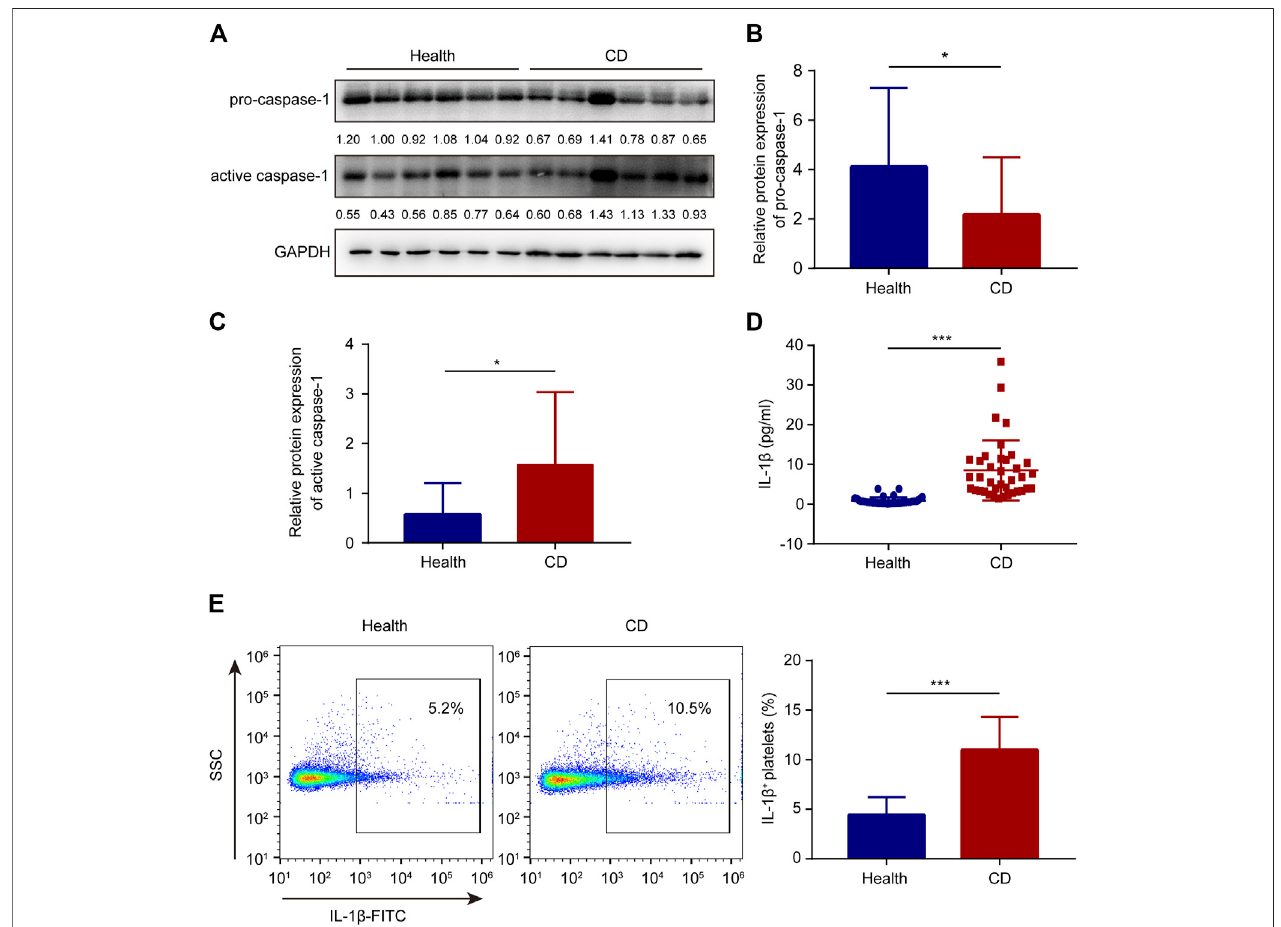
FIGURE 3| Increased interleukin-1 β and active caspase-1 in platelets from patientswithactive Crohn ’ s disease (CD). (A) The protein levels ofcaspase-1 and pro- caspase-1 in platelets from the healthy group and patients with active CD. (B,C) The relative protein quanti fi cation of pro-caspase-1 (B) and active caspase-1 (C) was determined ( n (cid:2) 38). (D) Serum interleukin-1 β levels were determined in the healthy group ( n (cid:2) 38) and patients with active CD ( n (cid:2) 38) by ELISA. (E) The ratio of interleukin-1 β -positive platelets was determined in the healthy group ( n (cid:2) 38) and patients with active CD ( n (cid:2) 38). Health, the healthy group; CD, the patients